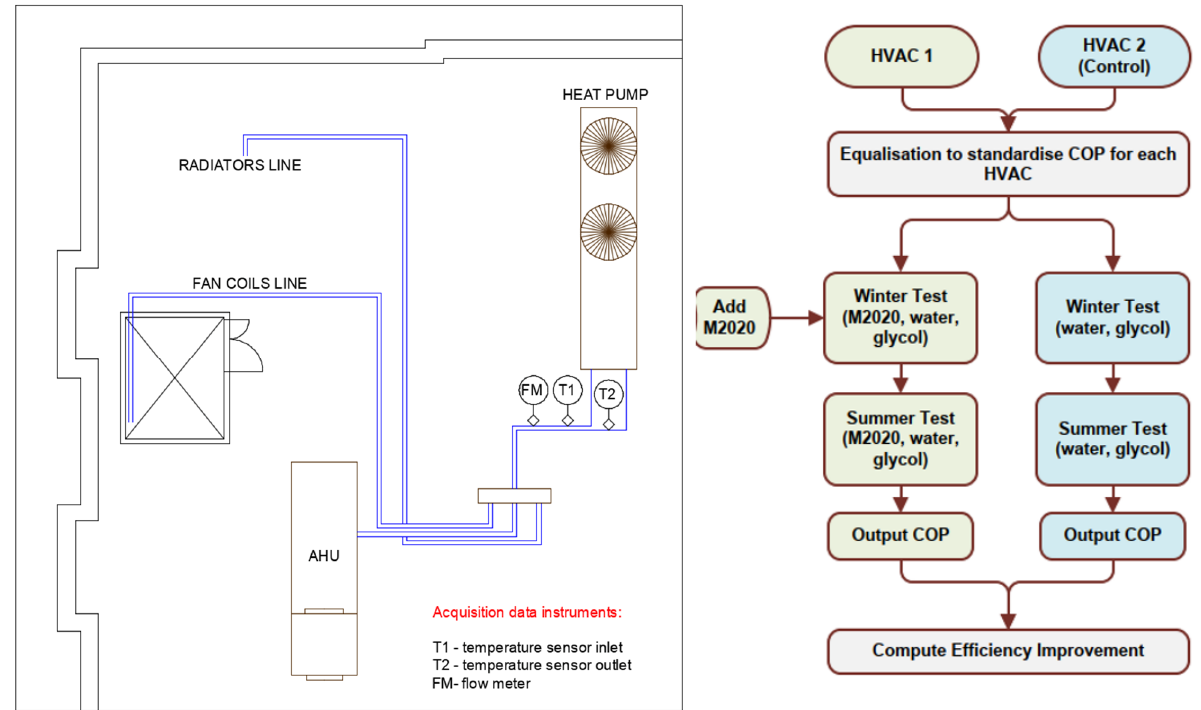
Figure 4. HVAC system with data sensors positions and flowchart of test methodology.